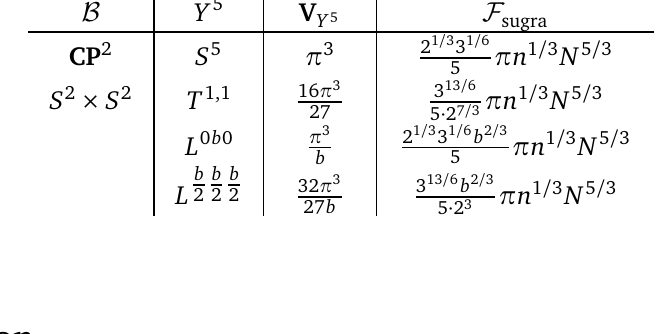
Table 1: The holographic S 3 free energy for various choices of internal manifolds. F B Y 5 V Y 5 sugra CP 2 S 5 π